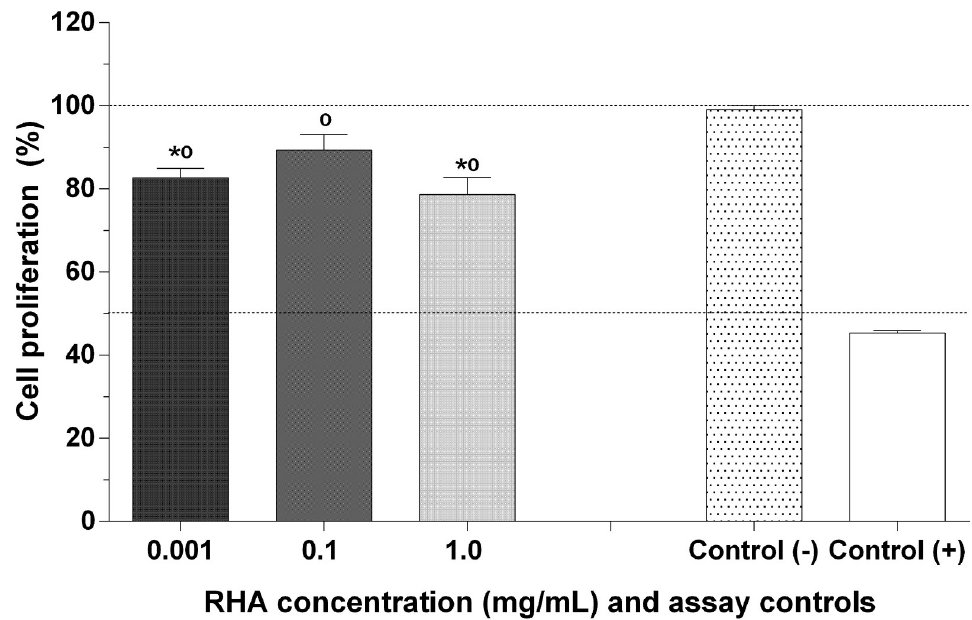
Fig 4. Antioxidant activity of RHA in cell culture. Concentration of extract (RHA): 0.001, 0.1 and 1.0 mg/mL. On the x-axis, there are the RHA concentrations (in mg/mL) and assay controls, and on the y-axis, the percentage of cell proliferation. Results expressed as mean ± standard error of the mean (n = 3). � : Statistical significance with the negative control;˚: Statistical significance with the positive control. Control (+): 3T3 cells with reduced metabolic activity by up to